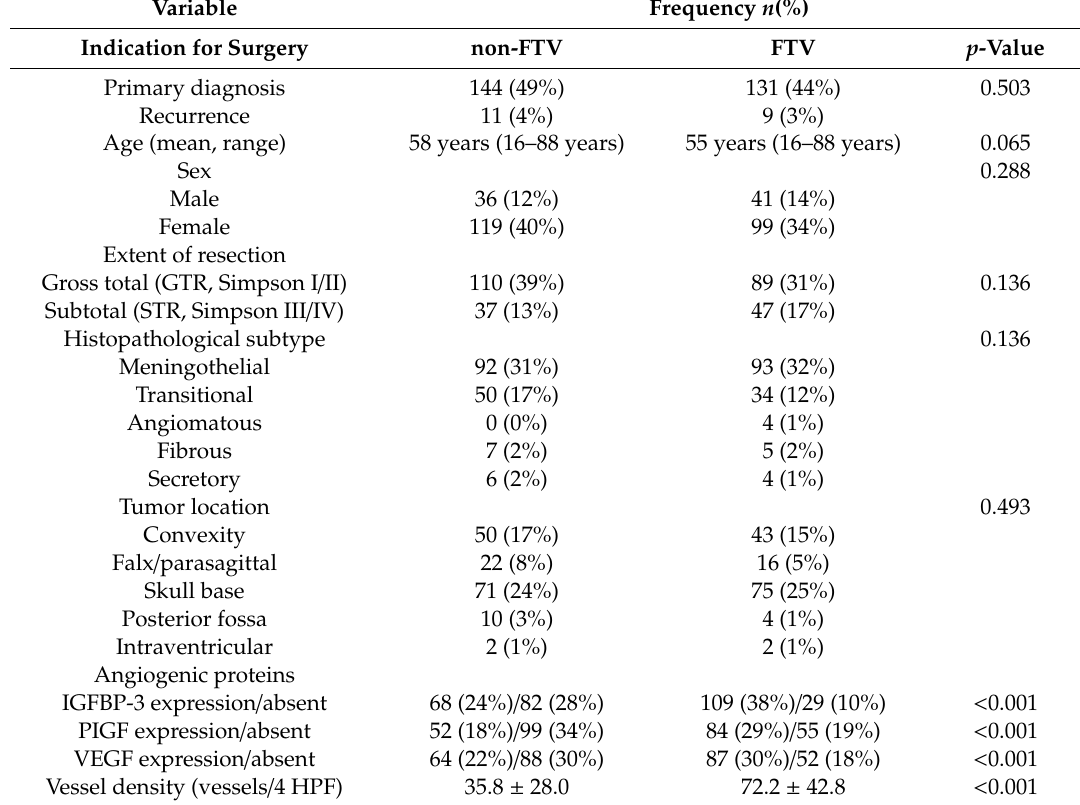
Table 2. Correlations between clinical and histopathological variables and fibrotic tumor vessels